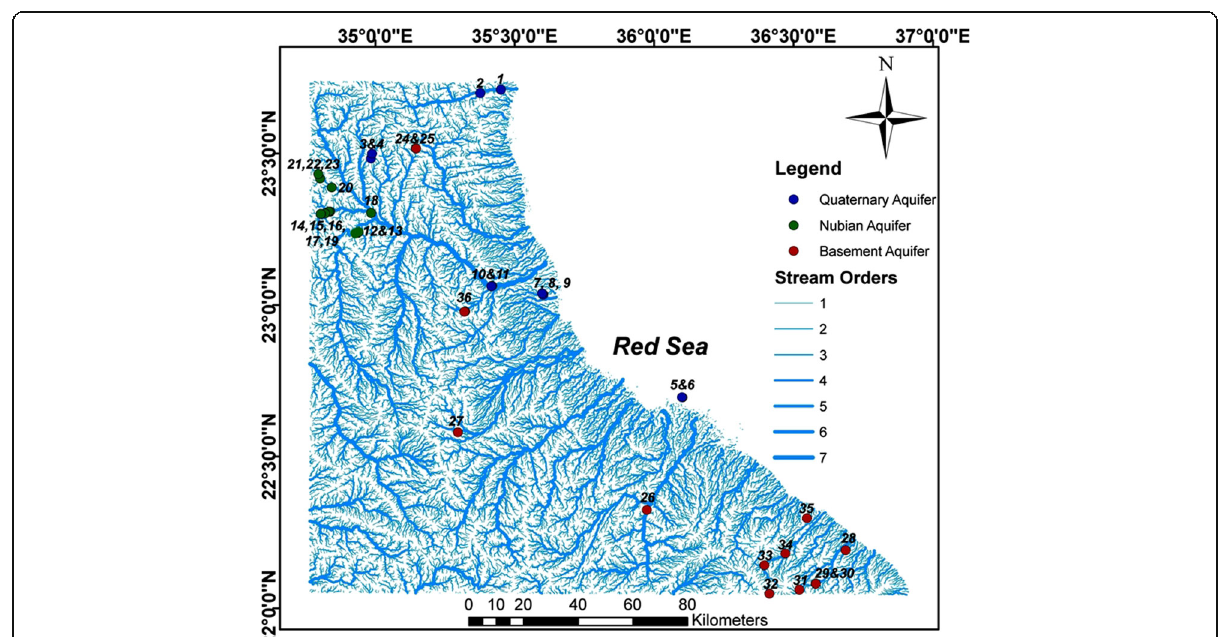
Fig. 10 Drainage network with stream orders of the study area